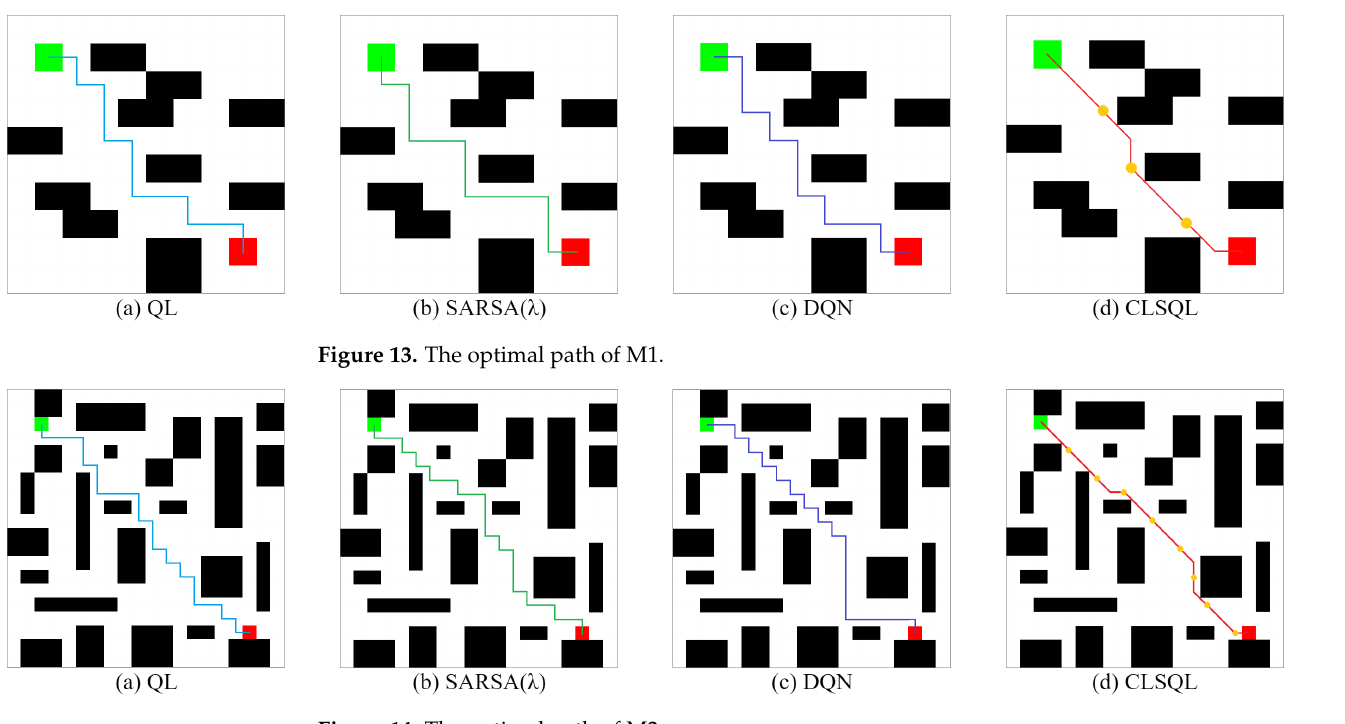
Figure 14. The optimal path of M2.